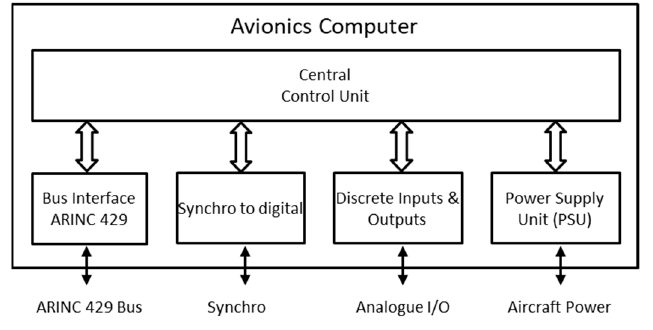
Figure 4. Rough architecture of a control computer.